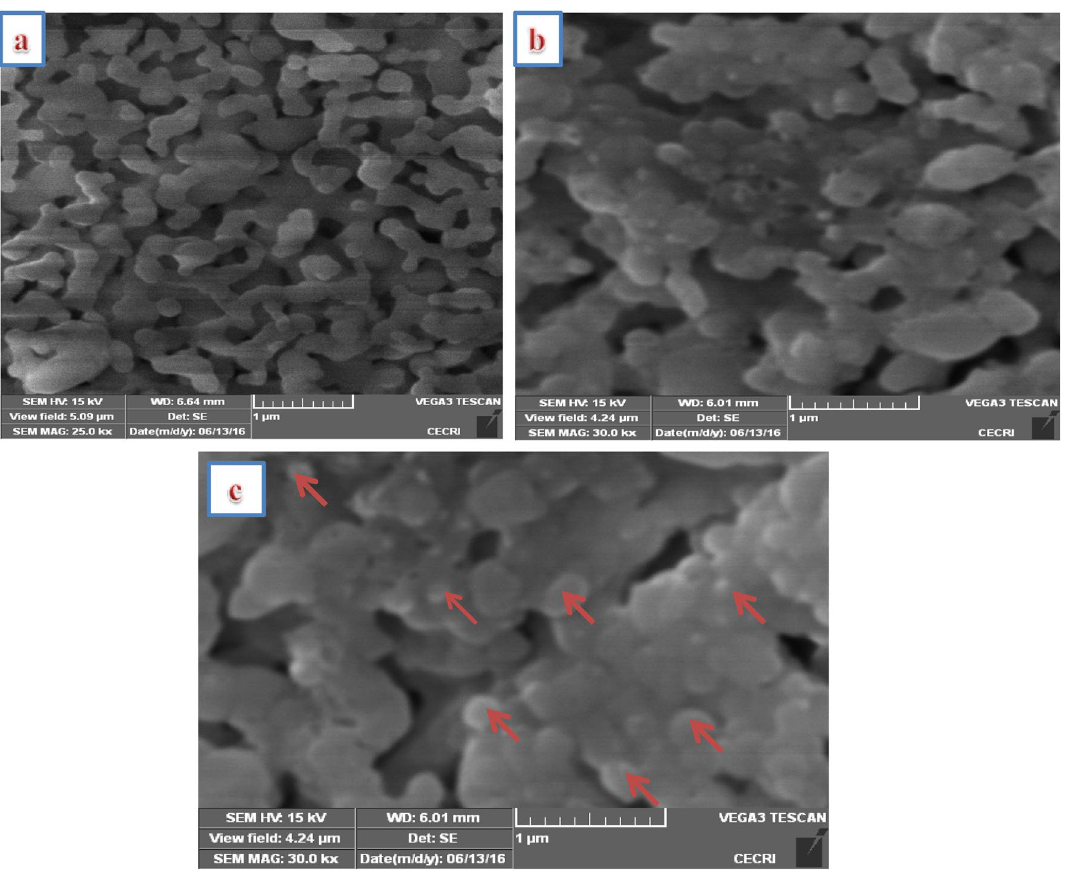
Fig. 11 SEM images of a CAP scaffold, b , c CAP scaffold in SBF solution after 5 and 7 days of immersion at pH of 7.4 and temperature of 37